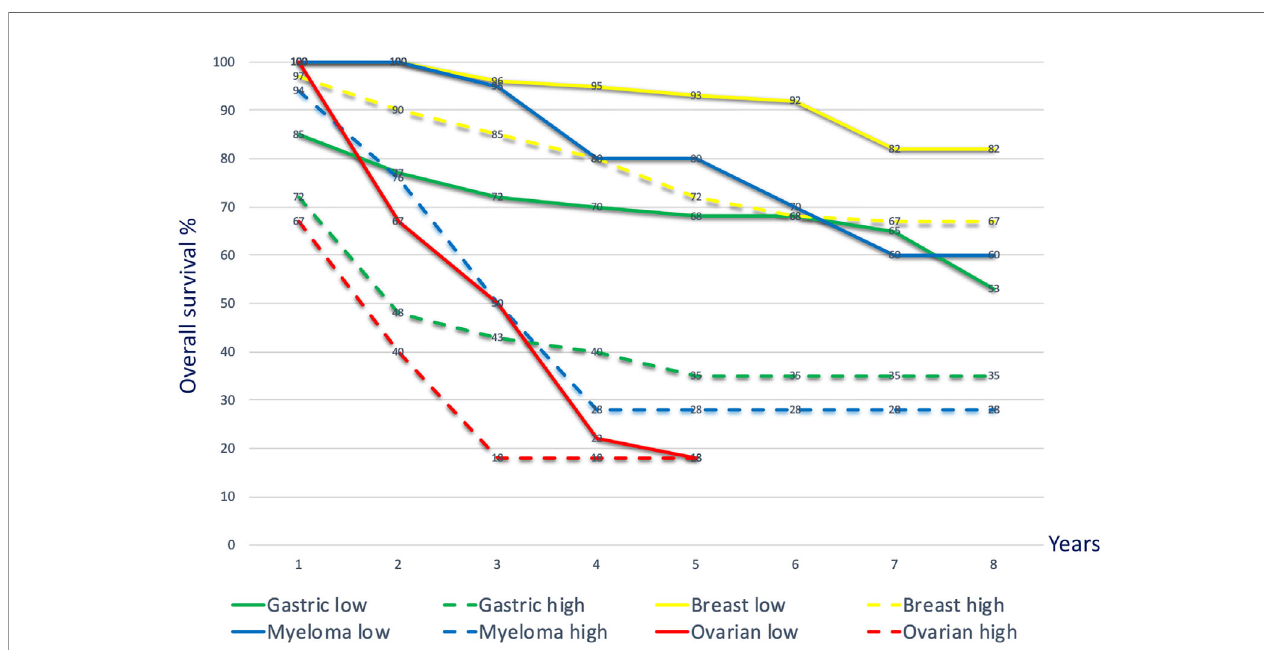
FIGURE 2 | Kaplan – Meier curves depicting overall survival for high and low TAM densities across different cancer types. Overall survival curves, merged data, various cancers. Gastric cancer: Kaplan – Meier overall survival curves for gastric cancer patients with high TAM density (> 671 cells in fi ve 400x microscopic fi elds; green dotted line) and low density (< 671 cells in fi ve 400x microscopic fi elds; green solid line). The TAM density in the tumor tissue was negatively associated with overall survival [p=0.0073; (86)]. Breast cancer: Kaplan – Meier curves showing signi fi cant correlation (p<0.001) with overall survival according to the numbers of M2 TAM (CD163 high: yellow dotted line; CD163 low: yellow solid line) (87). Multiple myeloma: overall survival outcome based on low and high CD163 TAM ( ≤ 55 per high power microscopic fi eld; solid blue line) vs. high CD163 TAM (> 55 per high power microscopic fi eld; dotted blue line) showing signi fi cant survival difference (p<0.001) (88). Ovarian cancer: Kaplan – Meier survival curves comparing high and low M1 (CD80)/M2 (CD163) ratios in patients with ovarian cancer. Patients with an M1/M2 ratio ≥ 1.4 (solid red line) showed a signi fi cantly higher overall survival (p=0.02) than those with an M1/M2 ratio < 1.4 (dotted red line)